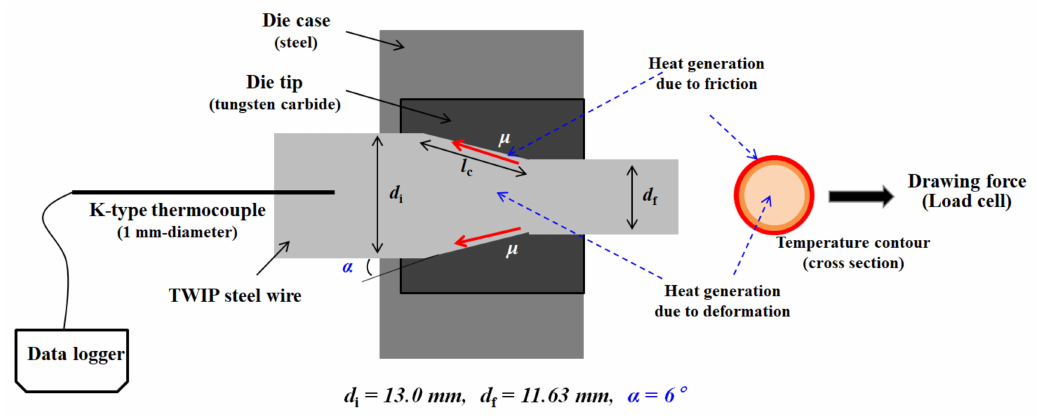
Figure 2. Schematic of the wire drawing process and terminology used in this